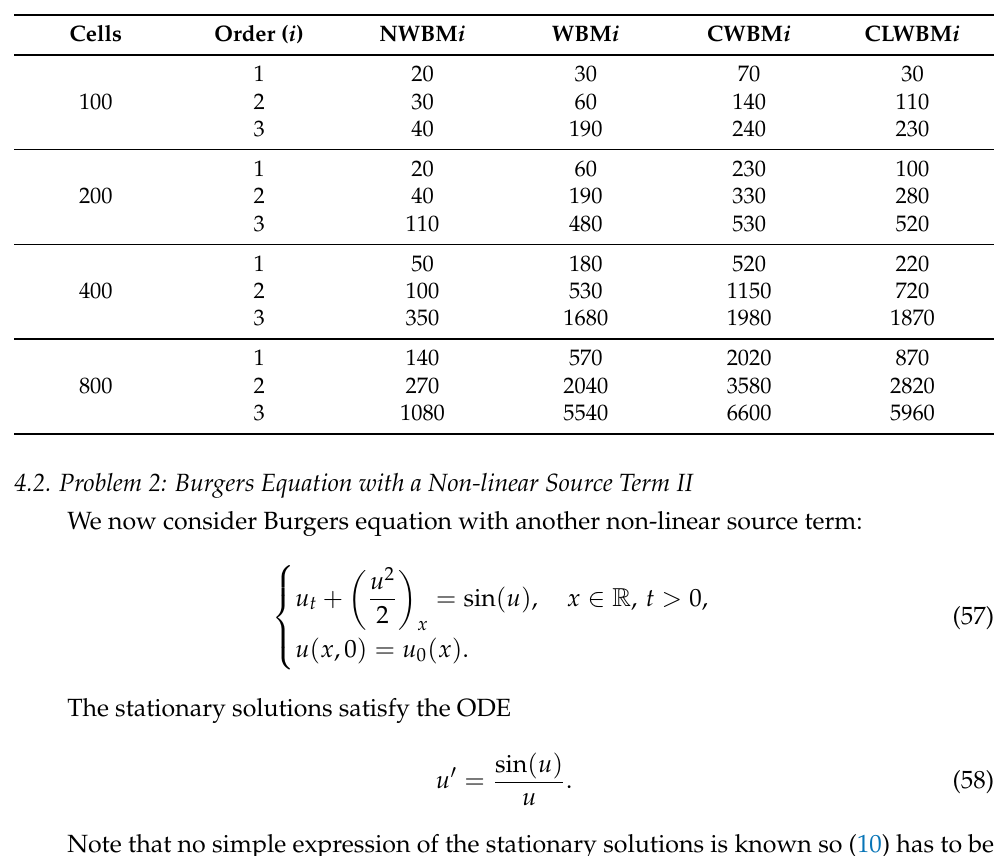
Table 4. Test 1.1. Computational times